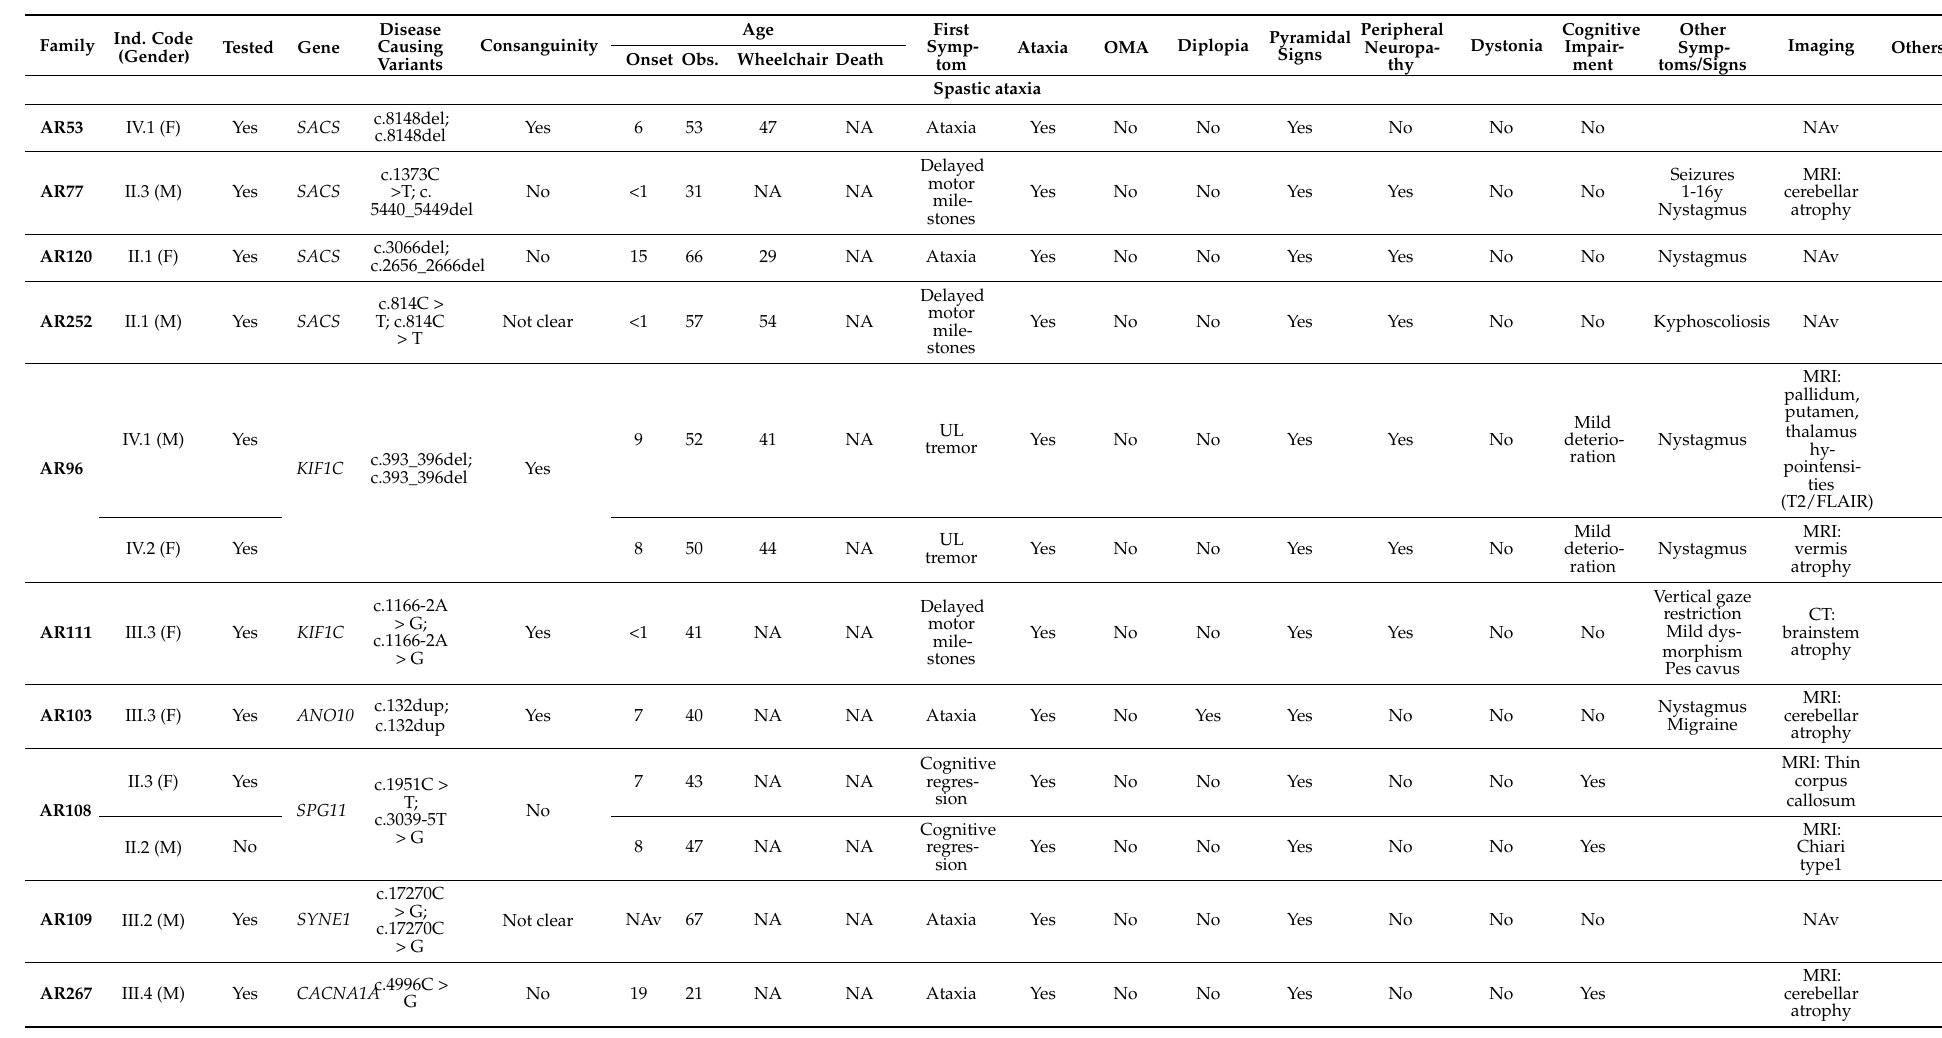
Table 1. Clinical characterization of the